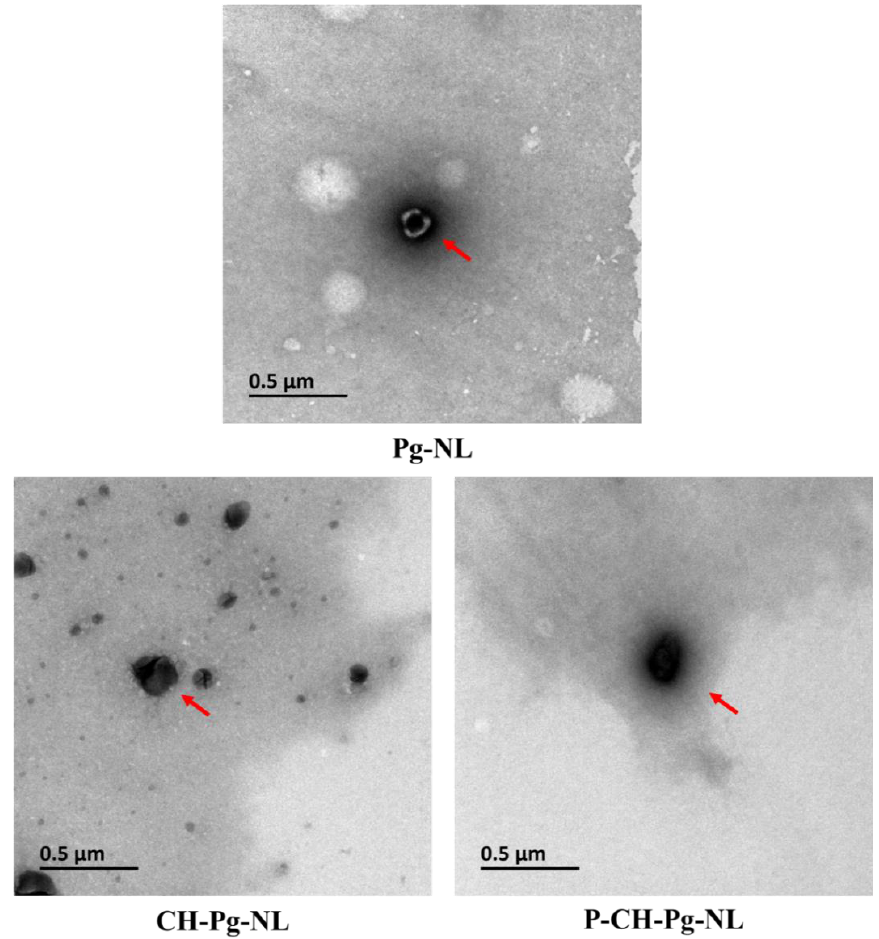
Figure 1. Transmission electron microscopy (TEM) analysis of Pg-loaded liposomal systems. Here, Pg-NL = Pelargonidin- 3-O -glucoside-loaded uncoated nanoliposomes; CH-Pg-NL = Pg-NL coated by chitosan; P-CH-Pg-NL = CH-Pg-NL coated by pectin.